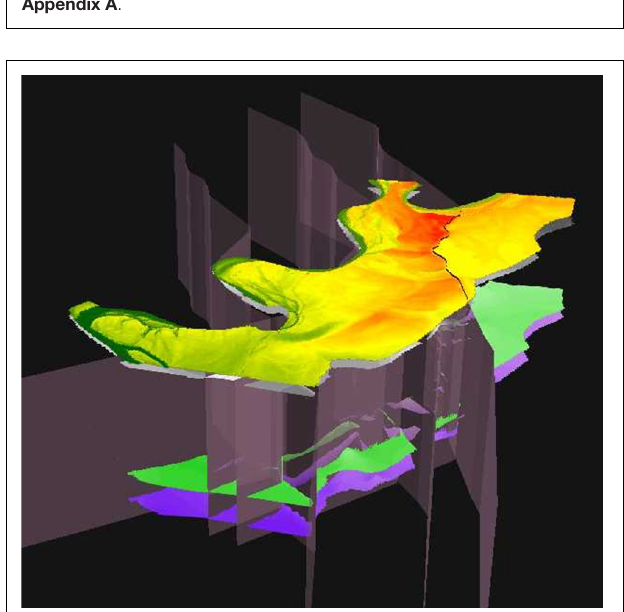
FIGURE 13 | 3-D Landscape Surface to Paleozoic Model of Lake County, Tennessee. Landscape surface (yellow), tops of Eocene (gray), Cretaceous (green), and Paleozoic (purple) shown as stacked layers based on elevation (m). Faults shown as vertical planes slicing through the geologic surfaces. Vertical exaggeration = 15. Animation in Supplementary Appendix B